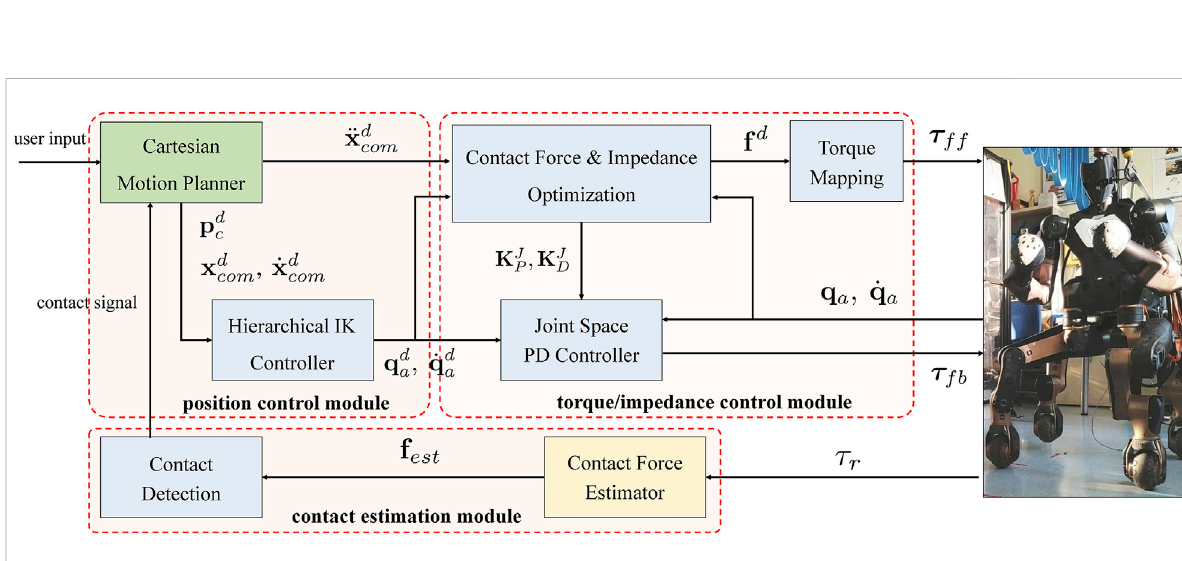
FIGURE 2 An overview diagram of the proposed control pipeline for legged locomotion. The dashed boxes represent the position control module, the torque/impedance control module and the contact estimation module, respectively. The color of blocks indicates execution frequency: the block with green shade runs at 10 Hz, the blocks with blue shade run at 200 Hz and the block with yellow shade runs at 400